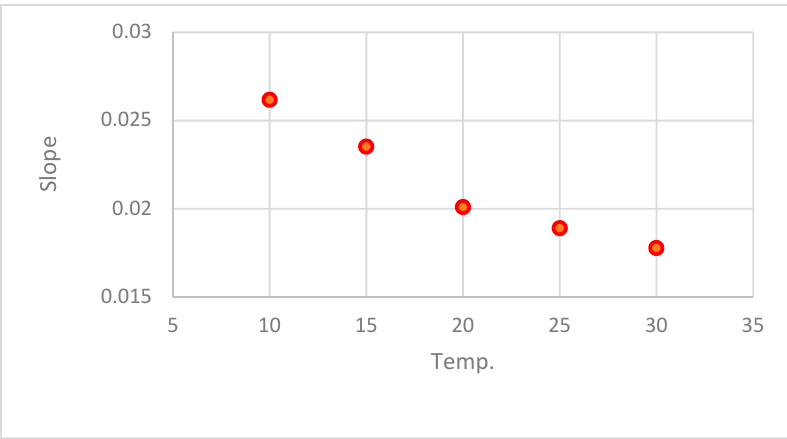
Figure 4. Effect of temperature on parameter B (slope) of the linear equation.